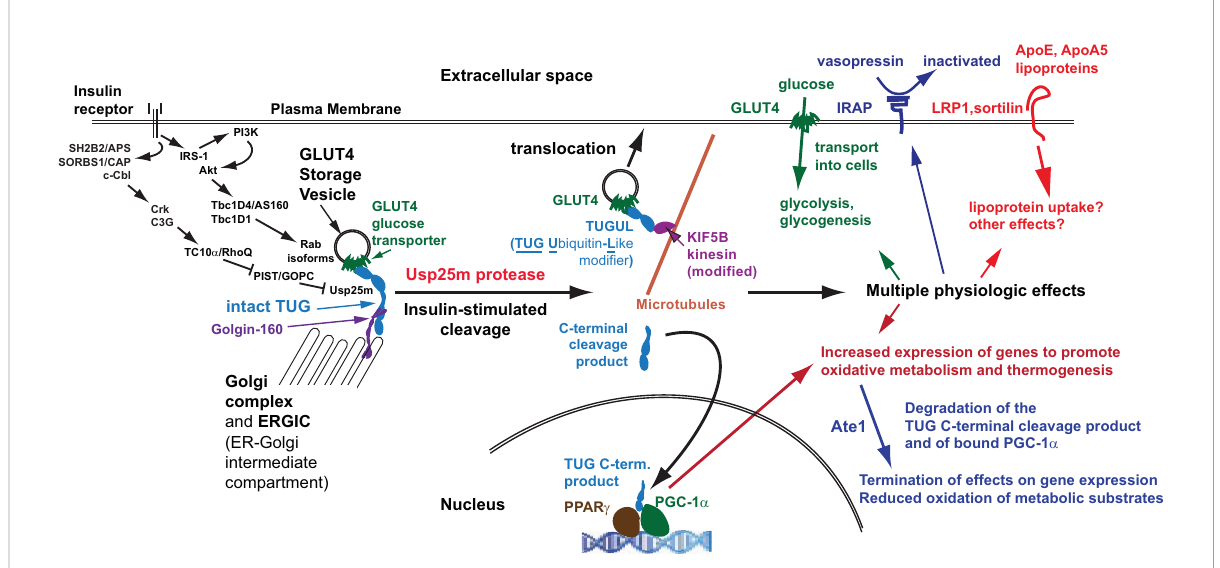
FIGURE 4 Coordinated regulation of distinct physiologic effects. Insulin signals through at least two signaling cascades to mobilize GLUT4 storage vesicles (GSVs). One involves Akt and the RabGAPs, Tbc1D4 and Tbc1D1, which regulate distinct Rab proteins on the GSVs (and on other membranes, such as endosomes). A second pathway involves the Rho family GTPase TC10 a , which is coupled through its effector PIST to the TUG protease, Usp25m. Insulin stimulates TUG endoproteolytic cleavage to liberate the GSVs from Golgi matrix proteins, including Golgin-160 and others not shown. The N-terminal cleavage product, TUGUL, is a ubiquitin-like modi fi er. In adipocytes, TUGUL is attached to KIF5B, a microtubule motor that carries the GSVs to the cell surface; in muscle, this or another kinesin may be involved. Fusion of these vesicles at the cell surface results in the insertion of their speci fi c cargo proteins into the plasma membrane. These include GLUT4, which promotes glucose uptake, IRAP which cleaves and inactivates circulating vasopressin, and LRP1 and sortilin, which bind the lipoproteins ApoE and ApoA5 and may regulate lipid metabolism. These proteins may have other effects as well. The TUG C-terminal product is extracted from the Golgi matrix by the action of p97 ATPases and is targeted to the nucleus. It binds the transcriptional regulator PPAR g and its co-factor PGC-1 a , and stimulates the expression of genes to promote lipid oxidation and thermogenesis. The stability of the C-terminal product is regulated by the Ate1 arginyltransferase, and the product confers Ate1-dependent stability on PGC-1 a . Degradation of these proteins makes their thermogenic effect transient, consistent with the transient increase in thermogenesis that is observed after